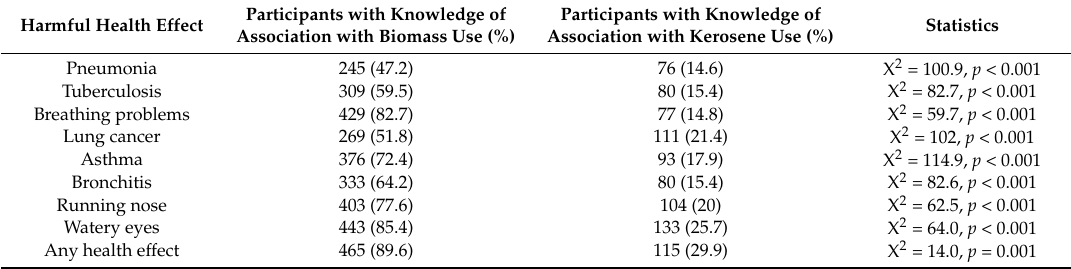
Table 4. Comparison of the knowledge of harmful health effects associated with cooking with biomass and